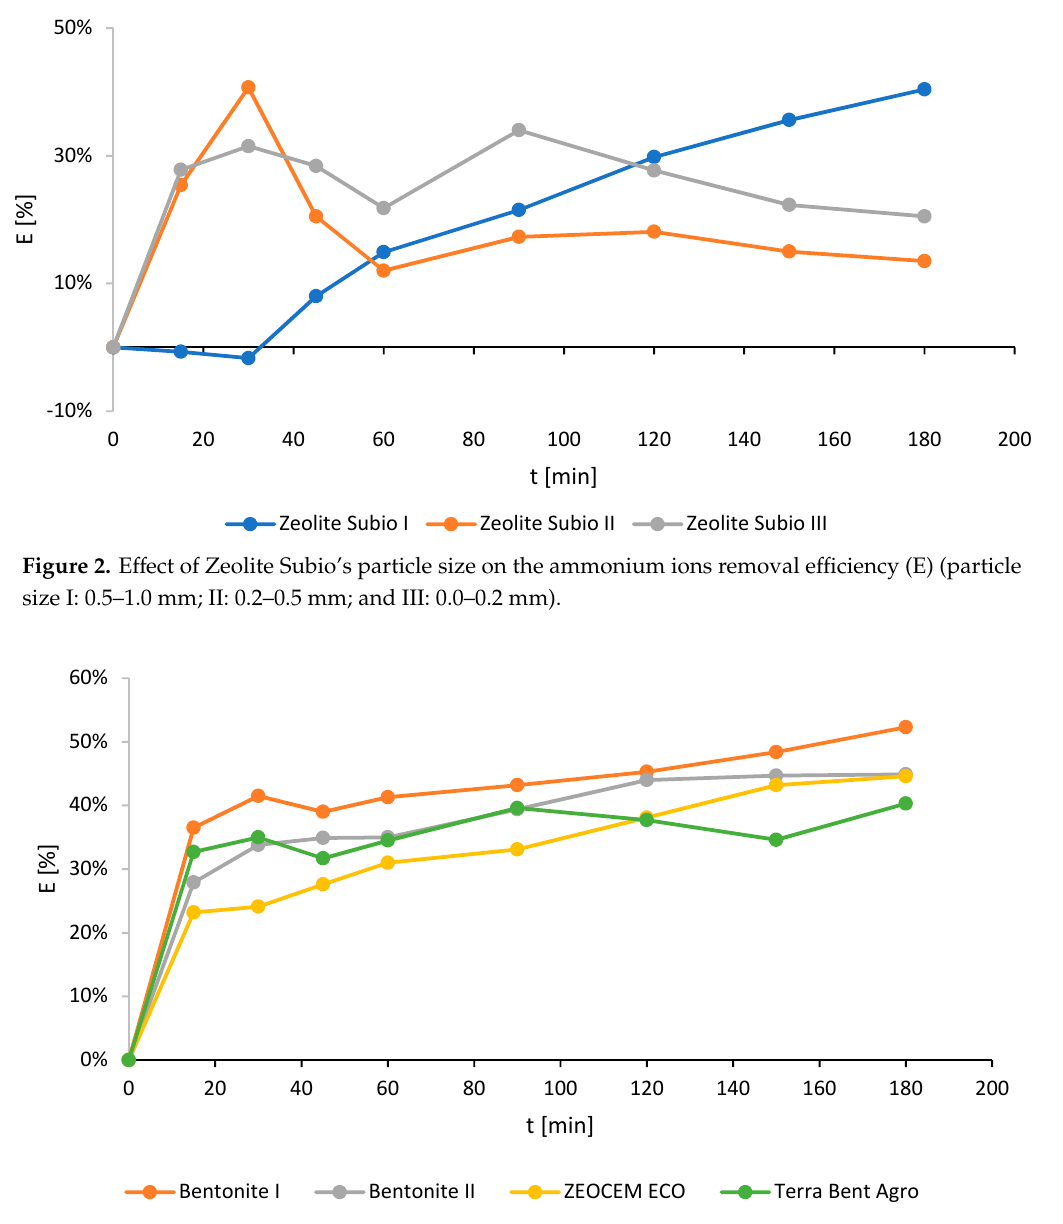
Table 1. Effect of using different sorbents on the NH 4+ adsorption capacity (q) and maximum removal efficiency (E) obtained in performed research.